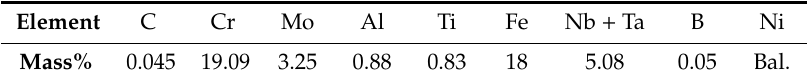
Table 1. The compositions of GH4169